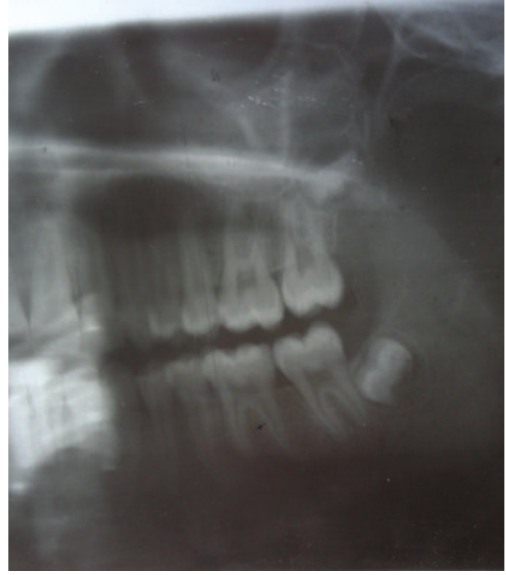
Figure 2: An orthopantomogram showing mottled unilocular ra- diolucency.